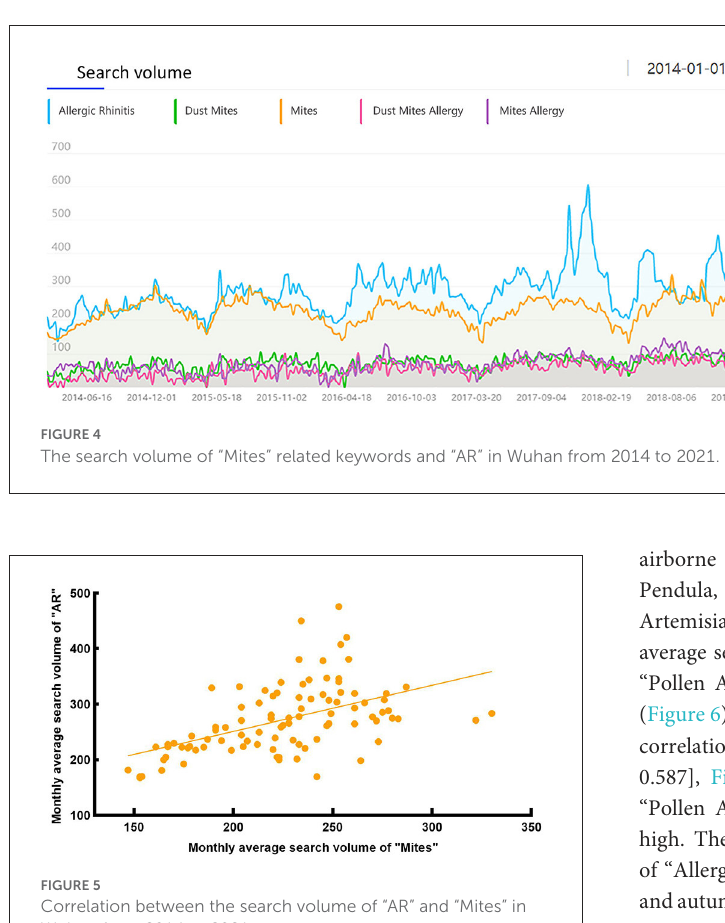
Pollen is one of the most common allergens.